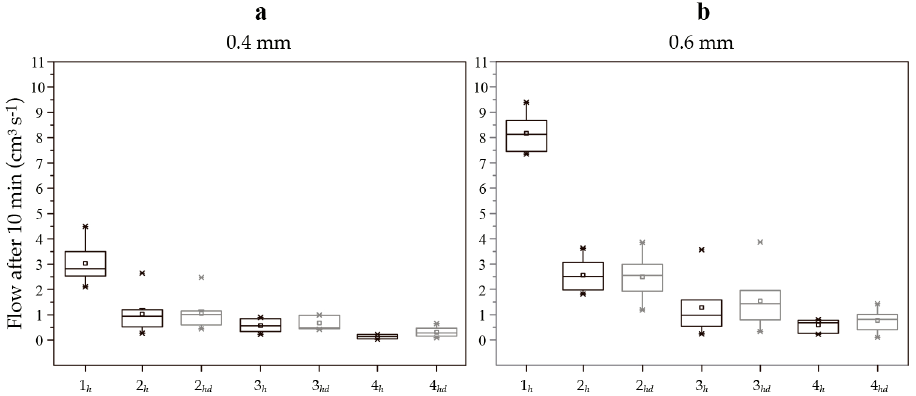
Figure 5. Box plot graphs depicting the permeability data for each series. Graph ( a ) shows the permeability data for specimens with cracks 0.4 mm wide and graph ( b ) shows the permeability data for specimens with cracks 0.6 mm wide. 1 h : Initial permeability for cracked unhealed mortar specimens; 2 h : Permeability of cracked mortar specimens after 56 days of submersion in seawater at 8 °C; 2 hd : Permeability of the 2 h specimens after drying; 3 h : Permeability of cracked mortar specimens with beads containing mineral precursor compounds after 56 days of submersion in seawater at 8 °C; 3 hd : Permeability of the 3 h specimens after drying; 4 h : Permeability of cracked bacteria ‐ based self ‐ healing cementitious specimens after 56 days of submersion in seawater at 8 °C; 4 hd : Permeability of the 4 h specimens after drying. Each box plot represents the permeability data for seven separate specimens. The square symbol of the boxes represents the mean permeability; the whiskers the minimum and maximum permeability values; and the top, middle and bottom lines the 75th, 50th and 25th percentiles, respectively.